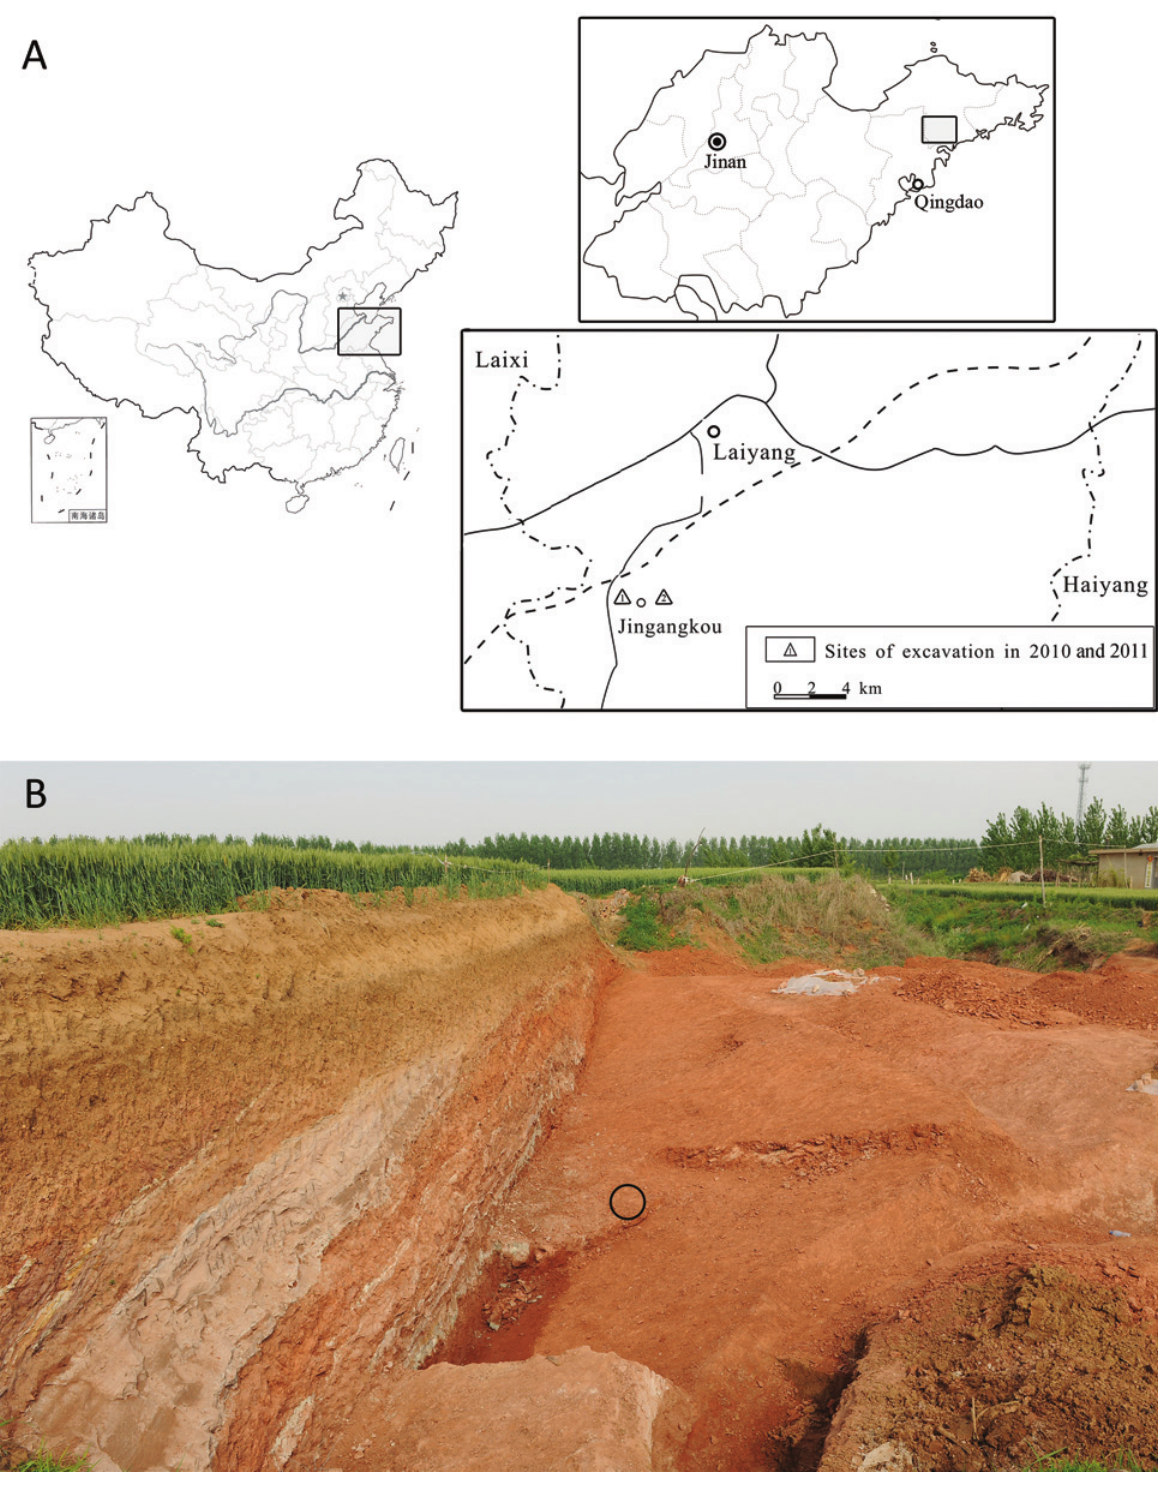
Fig. 1 - Locality of the turtle egg fossil in the Laiyang Basin, Shandong Province. A. sketch map of excavation sites in 2010 and 2011; B. the first excavation site showing the turtle egg position (the black